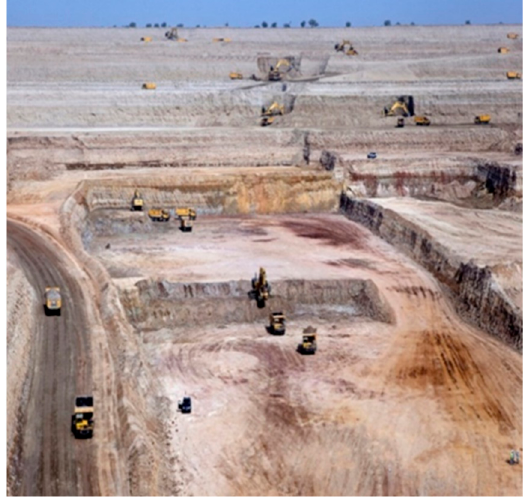
Figure 3. Operation at the Sindh Engro Coal Mining Company site in Thar Desert (source: Bloomberg).